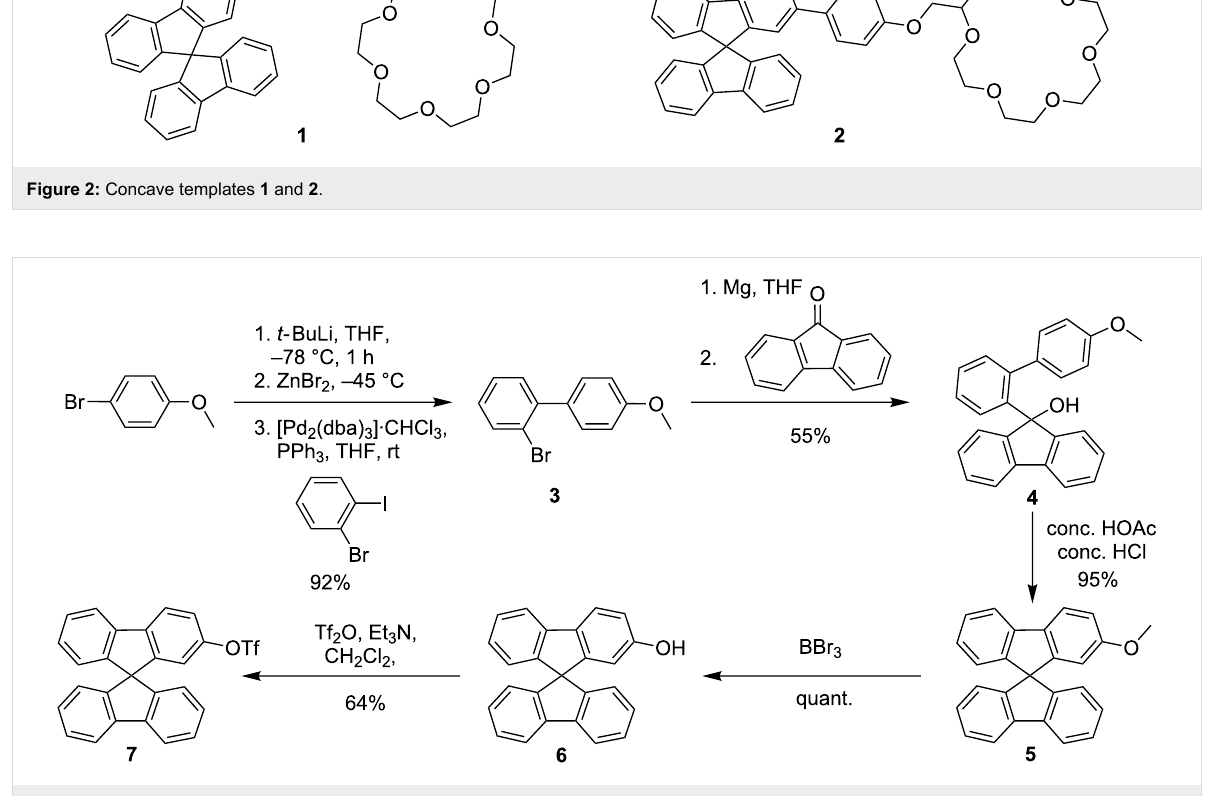
Scheme 1: Syntheses of the 2-(9,9’-spirobifluorene-2-yl)trifluoromethansulfonate ( 7